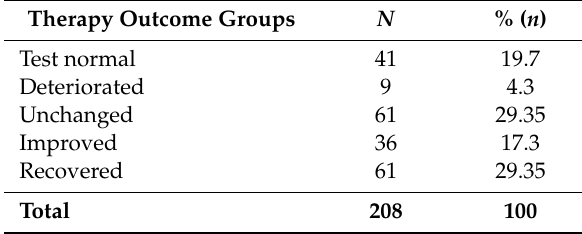
Table 3. Frequencies of therapy outcome groups N = 208 (by Jacobson and Truax 1991). Therapy Outcome